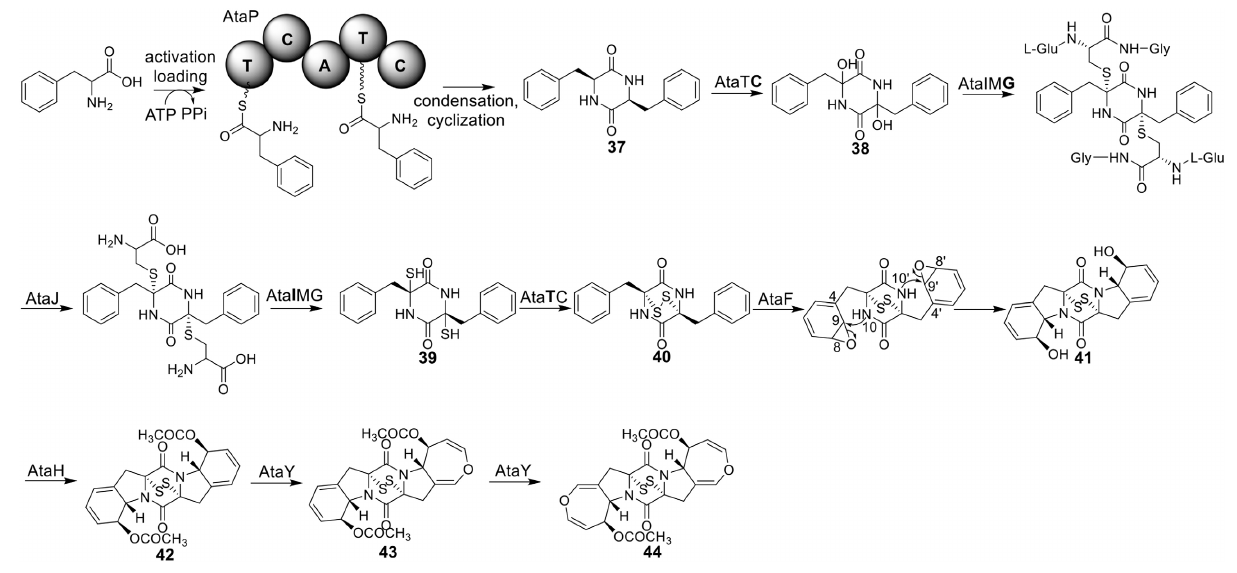
IDENTIFICATION OF THE PRODUCTS OF FOUR NRPS OR NRPS-LIKE GENES IN A.